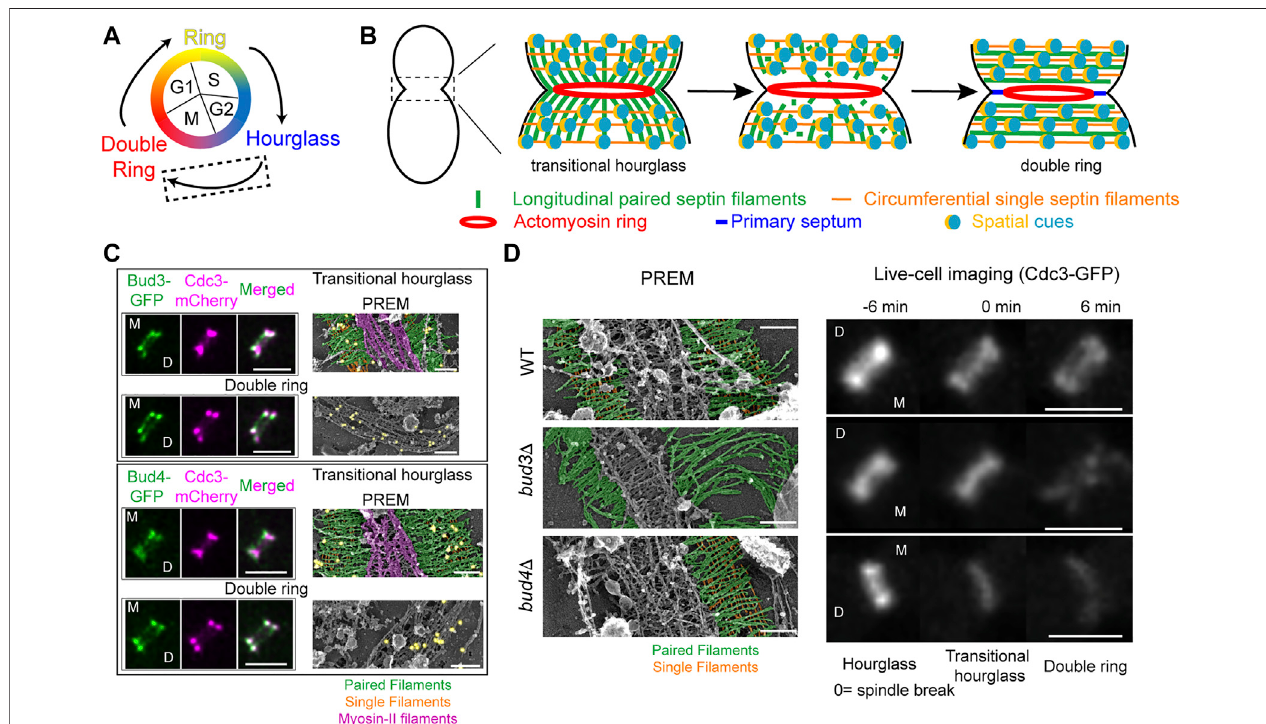
FIGURE 2 | Transitioning from an hourglass to a double ring. (A) Depiction of different septin structures visualized during the yeast cell cycle. Arrows indicate transitions occurring between two structures. Dashed box indicates that the focus of this fi gure is on the hourglass-to-double ring transition that occurs at the onset of cytokinesis. (B) A model of septin architectural remodeling at the division site. (C) Bud3 (green, top) and Bud4 (green, bottom) localization in relation to the septin hourglass and double ring (magenta) at the bud neck by iSIM. Scale bars (cid:1) 2 µm. Immunogold labeling PREM analysis of Bud3 (yellow, top) and Bud4 (yellow, bottom) localizationinrelationtotheseptintransitionalhourglassanddoublering (rightpanels) .Scalebar (cid:1) 200 nm.Paired fi laments(green),single fi laments(orange), and myosin-II fi laments (purple). Images taken from (Chen et al., 2020). (D) PREM analysis of the transitional hourglass (left panels) with paired fi laments pseudo- colored green and single fi laments pseudo-colored orange; scale bars (cid:1) 200 nm. Images taken from (Chen et al., 2020). Representative images of septin organization (Cdc3-GFP) at the bud neck during the HDR transition in WT (top) , bud3 Δ (middle) , and bud4 Δ (bottom) cells (right panels) . Scale bars (cid:1) 2 µm. Images taken from (Chen et al.,